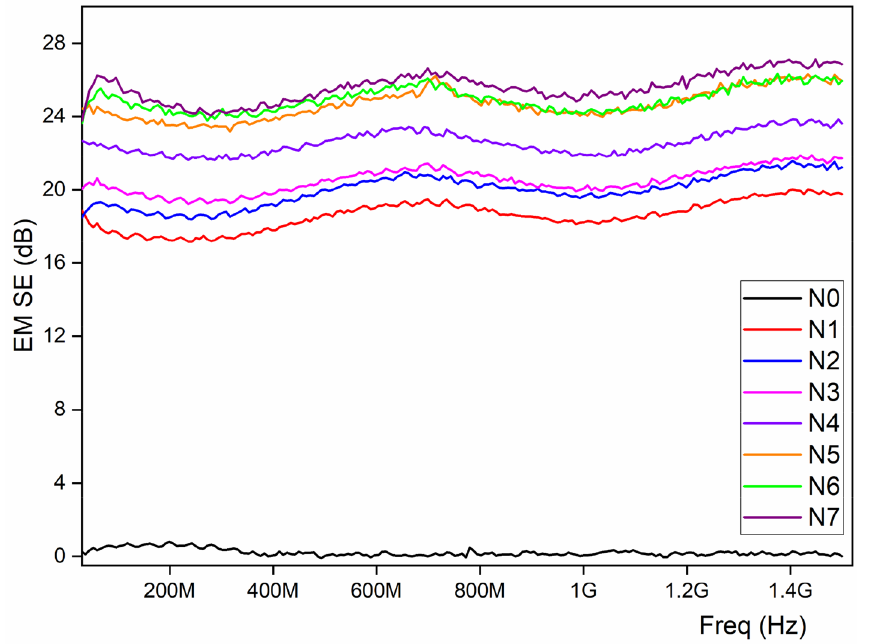
Figure 3. Influence of Ni/Cu concentration on the EM